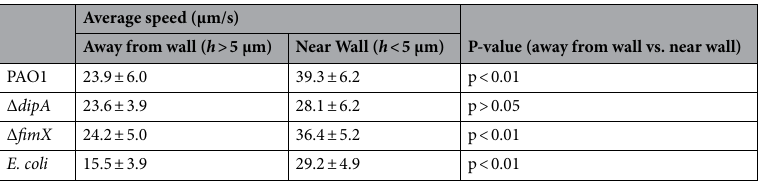
Table 1. The average swimming speed of PAO1, ΔdipA , ΔfimX and E. coli